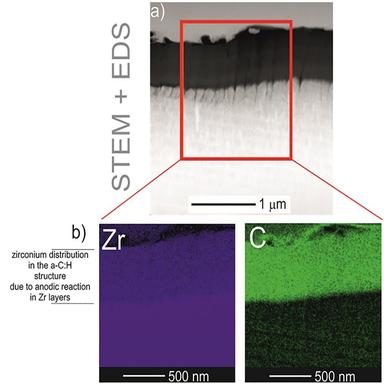
Qualitative chemical analysis of the Zr/Zr2N (1:4 ratio) multilayer coating with a-C:H top-layer coating performed on pitting corrosion region by EDS; a) STEM image with the marked region of analysis; and b) maps of selected element distribution.